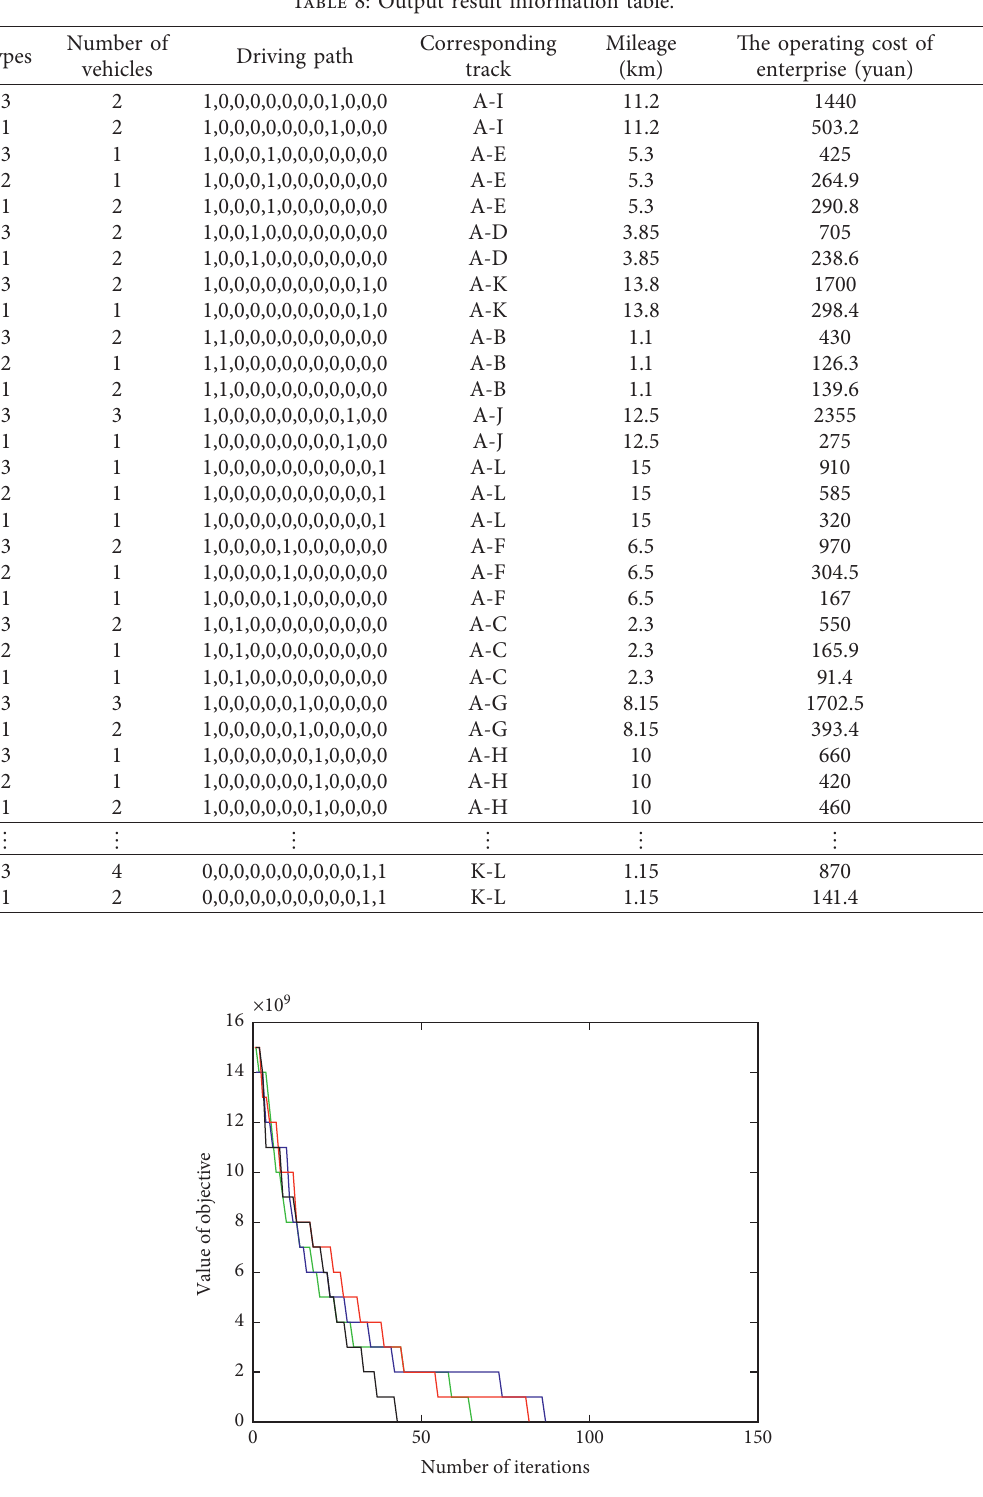
Table 8: Output result information table.